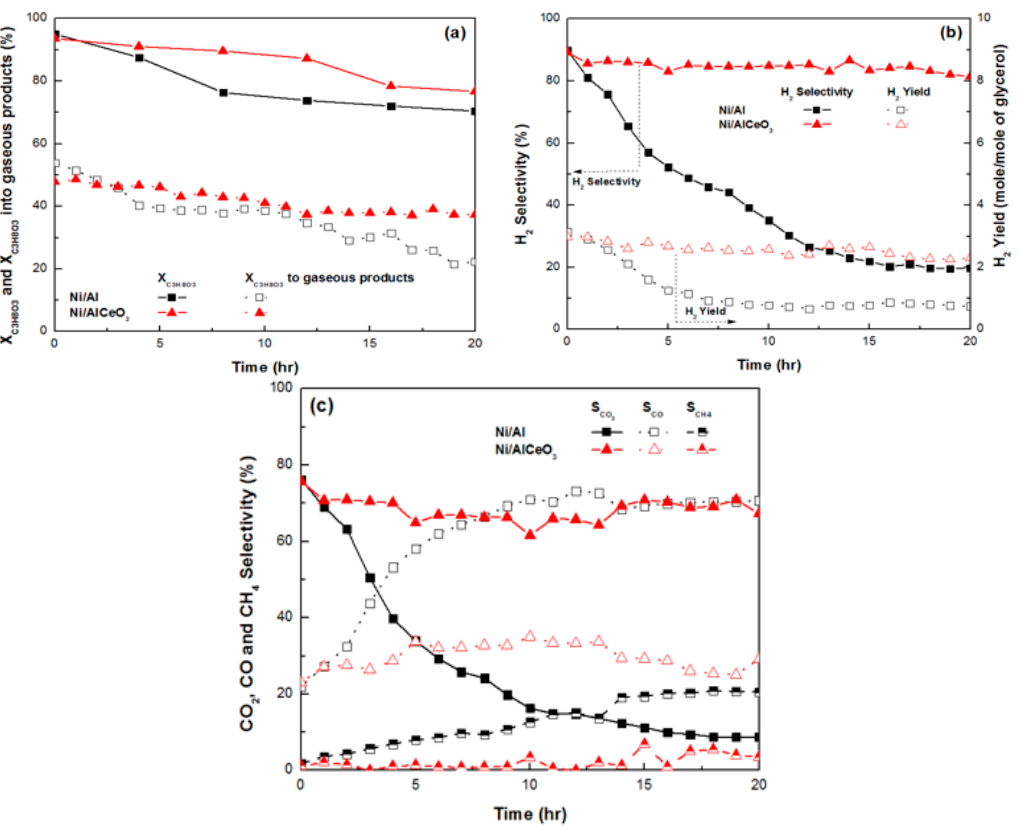
Figure 9. Time on stream experiments for Ni / Al 2 O 3 and Ni / AlCeO 3 catalysts: ( a ) Total glycerol conversion and glycerol conversion into gaseous products, ( b ) H 2 selectivity and yield, ( c ) CO 2 , CO and CH 4 selectivity (samples tested under experimental protocol #2).